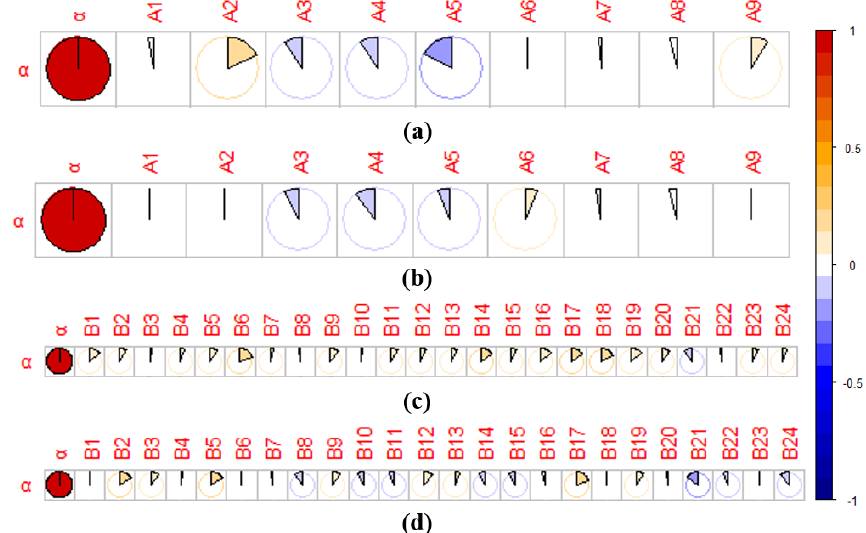
Figure 11. Pearson correlation coefficient between the variation in the amplitude α with multiple catchment features and climate variables. (a) Correlation between the absolute variation in amplitude α and catchment features; (b) correlation between the relative variation in amplitude α and catchment features; (c) correlation between the absolute variation in amplitude α and absolute variation in climate variables; (d) correlation between the relative variation in amplitude α and relative variation in climate variables.